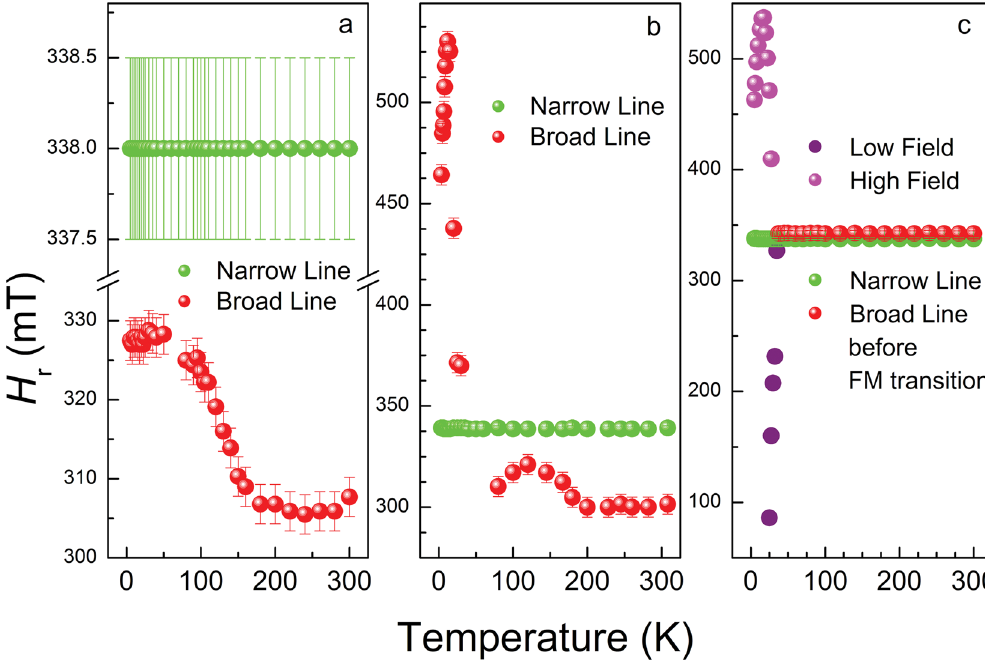
Figure 6. Resonance field positions H r of the EPR signal vs . temperature for Tabby graphene C 2 F x : ( a ) fluorine content x < 1 ; ( b ) aged sample with x ≈ 1 ; and ( c ) the same sample with x ≈ 1 as